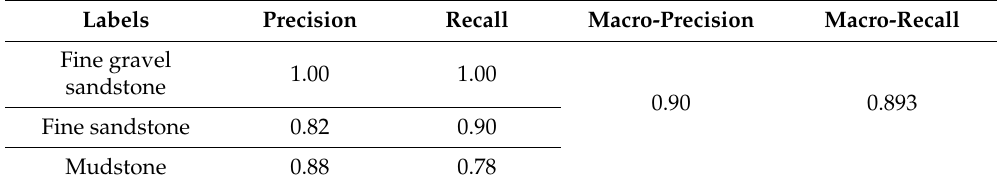
Table 6. Statistical indicators of test